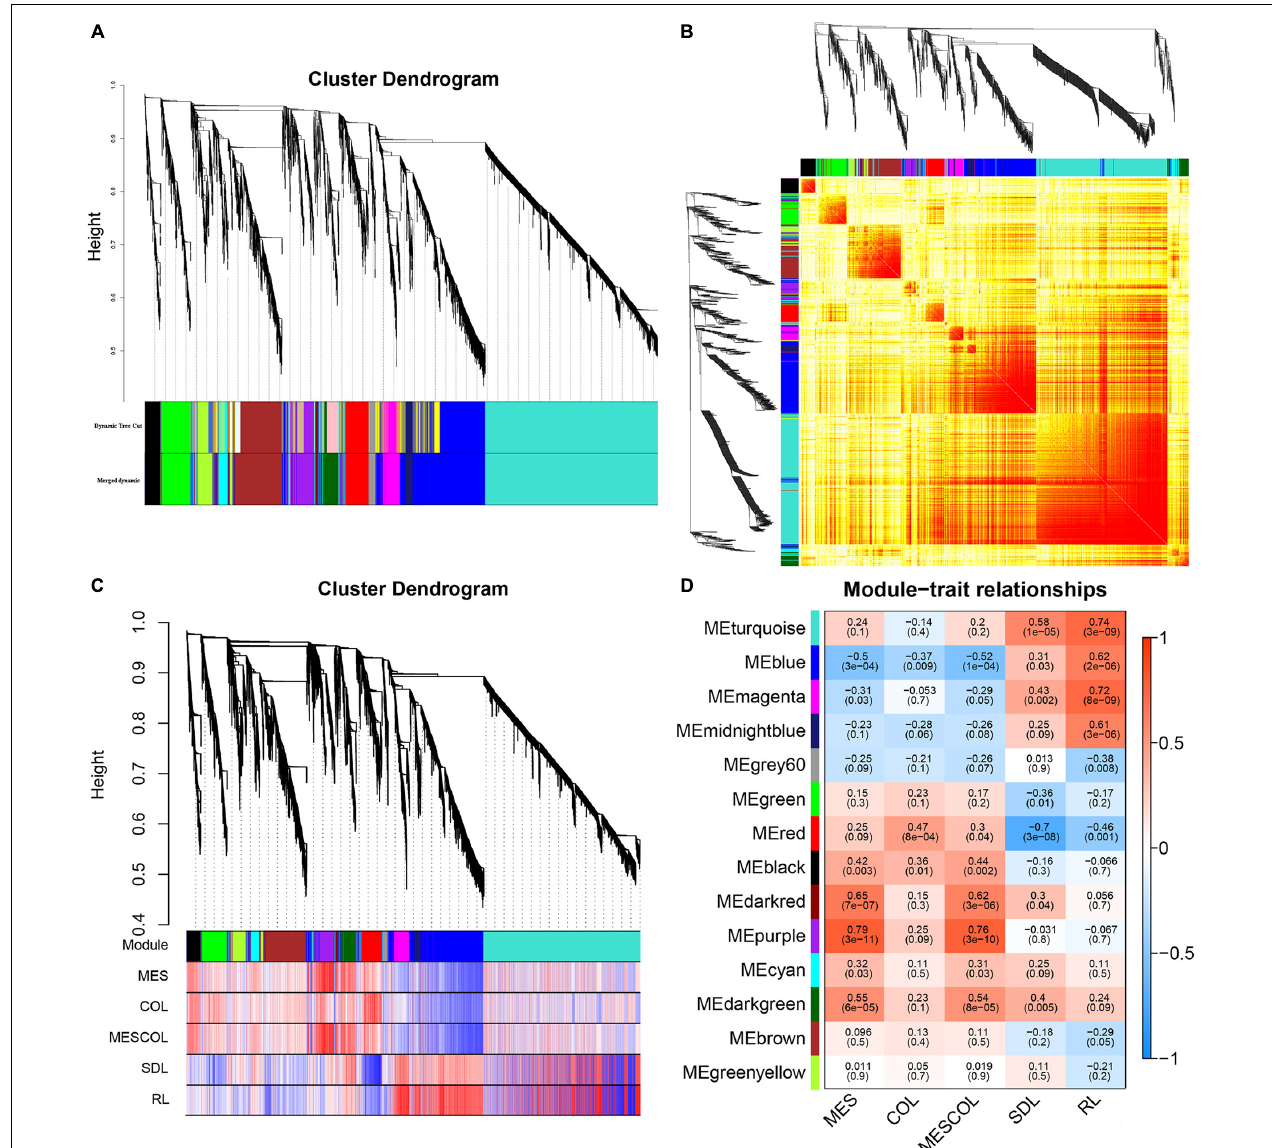
FIGURE 5 | Gene cluster analysis and correlation analysis between phenotype and module. (A) Hierarchical clustering analysis of co-expression genes. (B) Correlated heat maps between modules. (C) Correlation between gene module and phenotype. (D) Heat map of correlation between gene module and